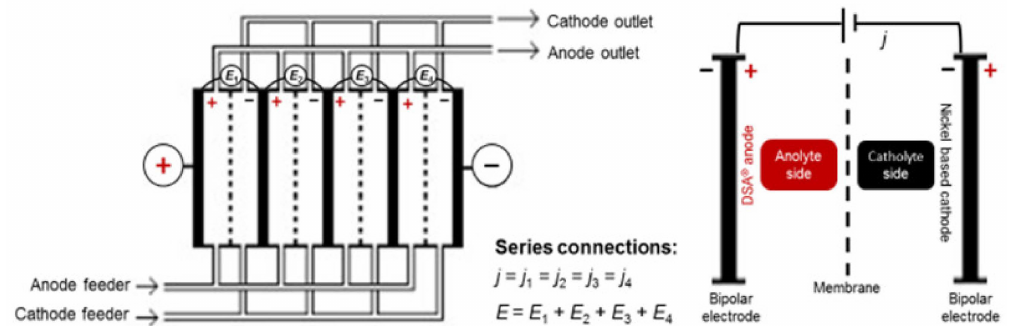
Figure 6. Scheme of a bipolar electrolyser where the stack consists of four cells connected in series: the potential between the terminals, E , is the sum of the individual cell potentials and the same current density, j , flows through the cells